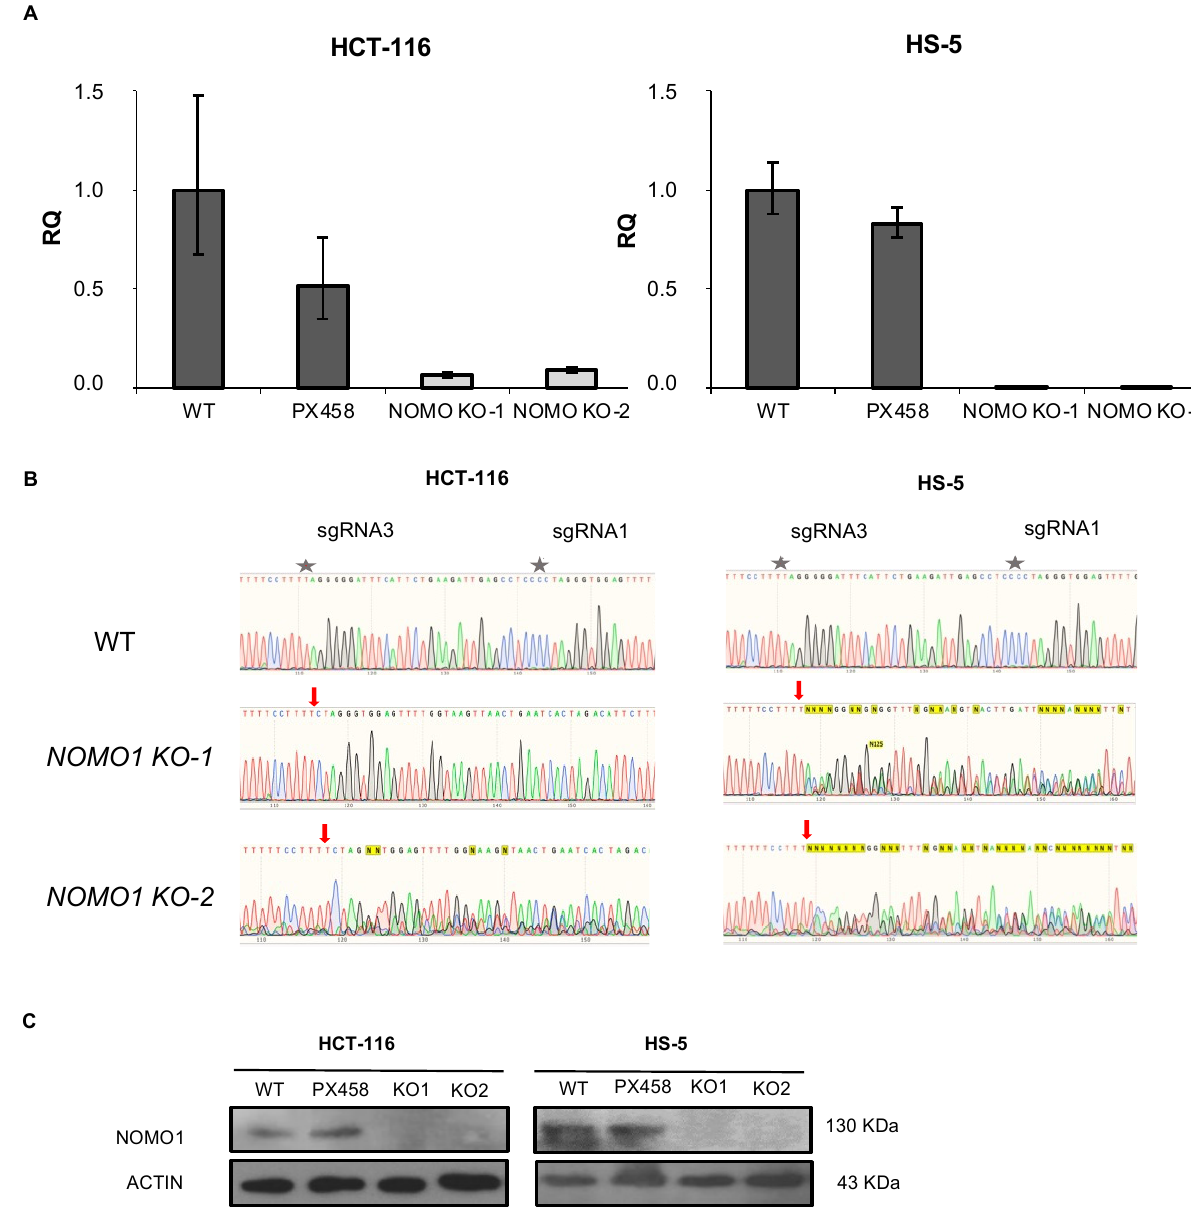
Figure 2. Generation of NOMO1-KO cell lines using CRISPR/Cas9 technology. ( A ) qPCR amplifica- tion of the fragment corresponding to the sgRNAs used in NOMO1-KO and control clones. The RQ was calculated according to the 2 − ∆∆ CT method, using the WT clones for normalization. Data are shown as the mean ± SD of three replicates. ( B ) Confirmation by Sanger sequencing of the reading frame change in the nucleotide sequence generated by Cas9 in NOMO1-KO clones. A red arrow marks the Cas9 breakpoint guided by sRNA1/sgRNA3. ( C ) NOMO1 expression by WB in WT and KO clones in HCT-116 and HS-5 cell